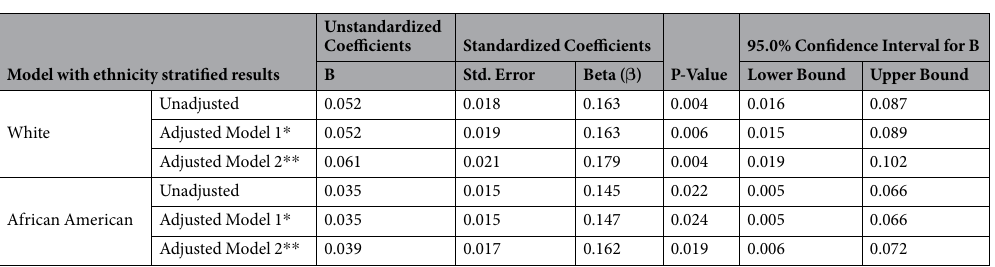
Table 5. Linear regression model partitioned by ethnicity. * Adjusting for Age, Gender, Ethnicity, BMI, Tanner Stage, Batch Effect. ** Adjusting for Age, Gender, Ethnicity, BMI, Tanner Stage, Batch Effect, Physical